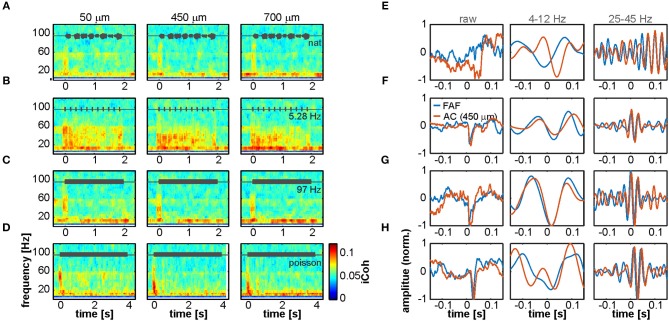
Interareal phase synchrony during acoustic sequence processing. (A–D) Mean time-resolved coherence between LFPs from the FAF and the AC at three representative depths (50, 450, and 700 μm), in response to the natural sequence (A), a syllabic train of 5.28 Hz (B), a syllabic train of 97 Hz (C), and the syllabic train with a Poisson structure (D). Note that low frequency synchrony is high even without acoustic stimulation, and the appearance of gamma-band evoked synchronization at the stimulus onset (time 0), albeit more weakly in response to the natural call in (A). (E–H) LFP recordings from the AC (orange) and FAF (blue) around the time of stimulus onset (at 0 s; order in E–H corresponds to order in A–D), from single trials in a representative penetration. Left column depicts the raw LFP, whereas middle and right columns depict field-potentials filtered in 4–12 and 25–45 Hz low-frequency and gamma-bands, respectively.